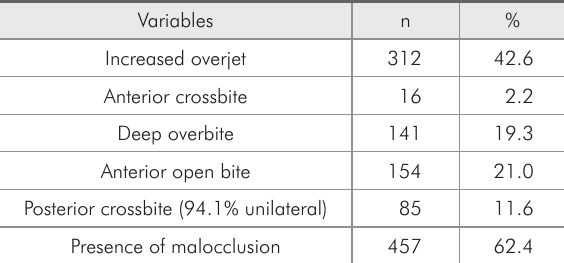
Table 1 - Prevalence of malocclusion and types of maloc- clusion in 3-5-year-old children.